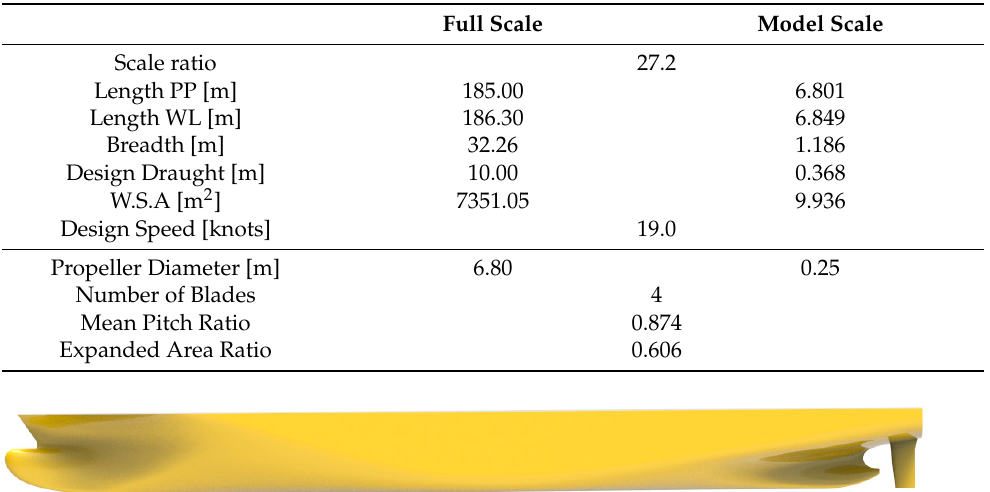
Figure 5. Three ‐ dimensional shape of the DS2500TEU LNG fuel feeder container ship. Figure 5. Three-dimensional shape of the DS2500TEU LNG fuel feeder container ship.